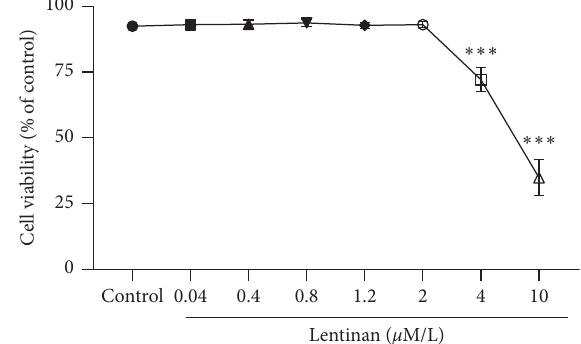
Control 0.04 Figure 4: Viability of HUVECs treated with different concentra- tions of lentinan. Lentinan concentrations were 0 (control group), 0.04, 0.4, 0.8, 1.2, 2, 4, and 10 μ M, and the values were expressed as mean ± standard deviation ( n � 4). Compared with the control group, ∗∗∗ P < 0 .